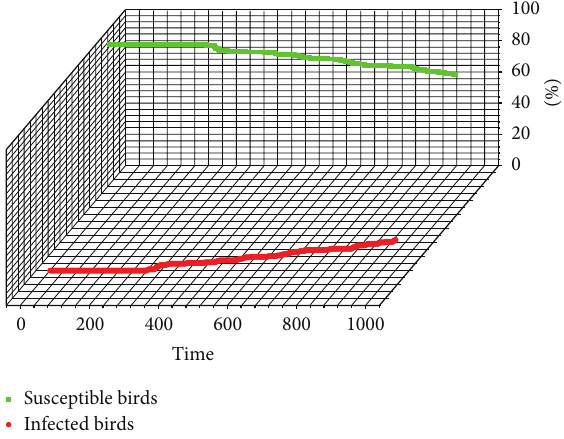
Figure 7: The epidemic status of the flocking birds.